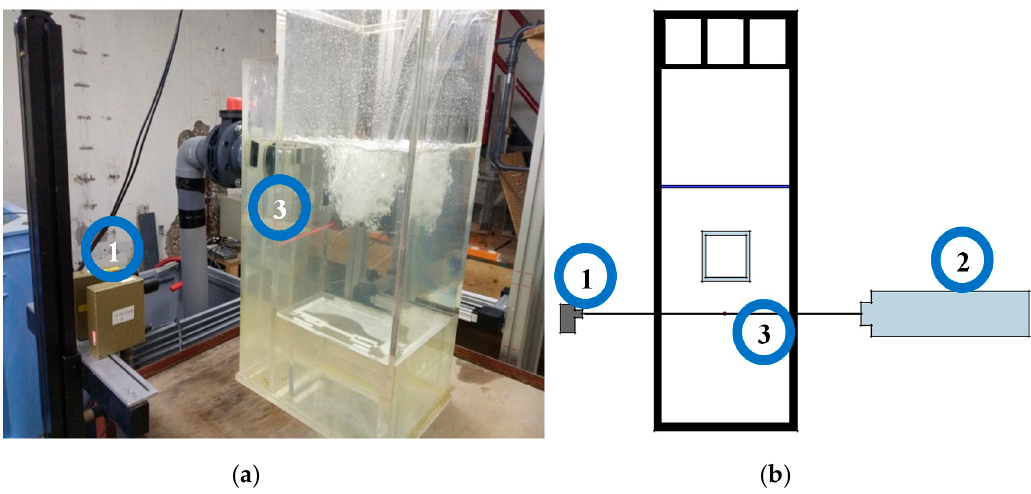
Figure 4. Laser Doppler Anemometry (LDA) setup. 1. Optical receiver 2. Laser 3. Laser beam ( a ) Photo of the setup; ( b ) Schematic drawing of the setup.